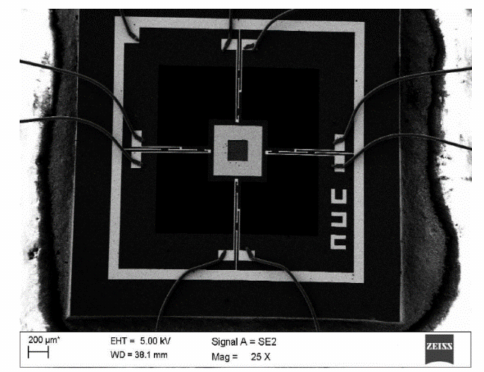
Figure 9. SEM diagram of MEMS four-beam microstructure.